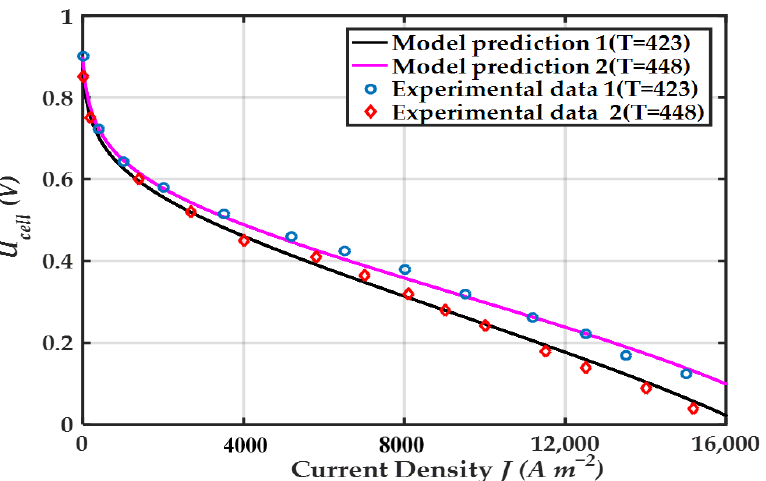
Figure 2. Comparisons of the HT-PEMFC single cell output voltage between modeling results and the experimental data.